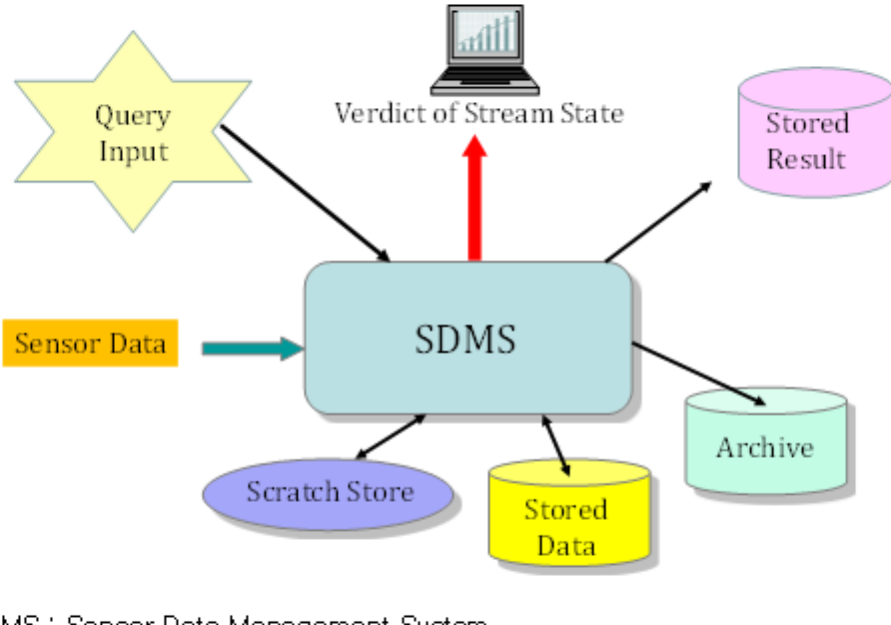
Figure 8. Smart sensor database system configuration.